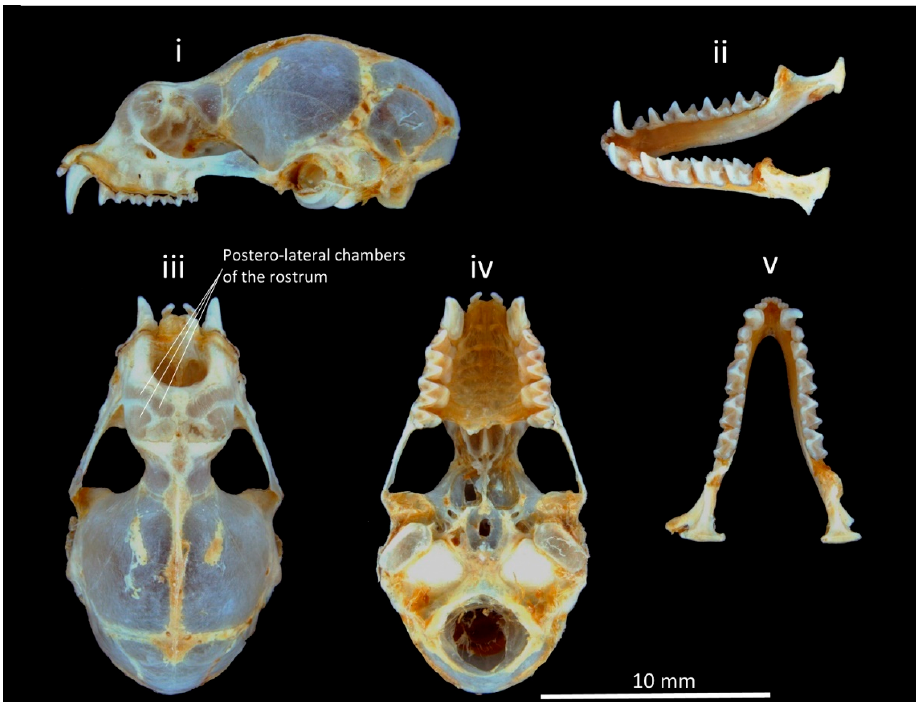
Figure 2. Craniodental characters (skull and mandible) of H. nicobarulae : ( i ) lateral view of maxilla; ( ii ) lateral-ventral view of mandible; ( iii ) dorsal view of maxilla; ( iv ) ventral view of maxilla; and ( v ) occlusal view of mandible.